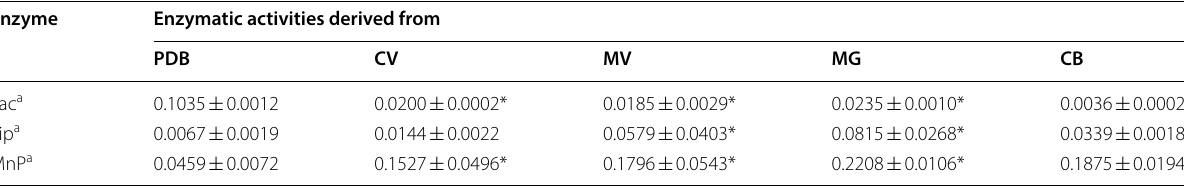
Data presented with standard deviation of mean ( Asterisk “*”indicates significant difference in enzymatic levels from those in potato dextrose broth based on T -test ( p < 0.05)